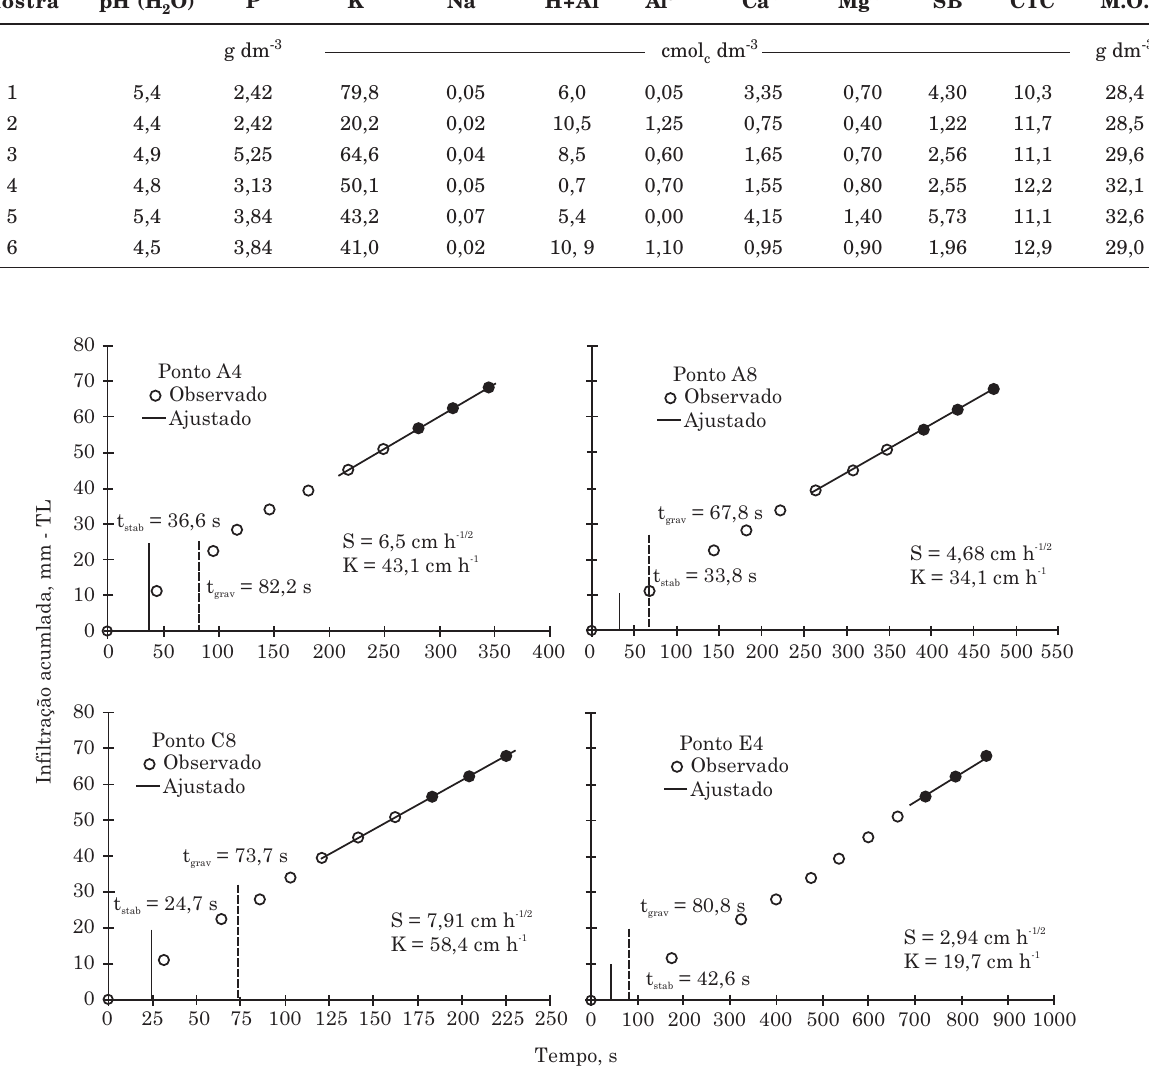
Figura 2. Gráficos das curvas experimentais e ajustadas de infiltração acumulada (mm) versus tempo (s) dos pontos A4, A8, C8 e E4. Os círculos fechados referem-se à infiltração do soluto